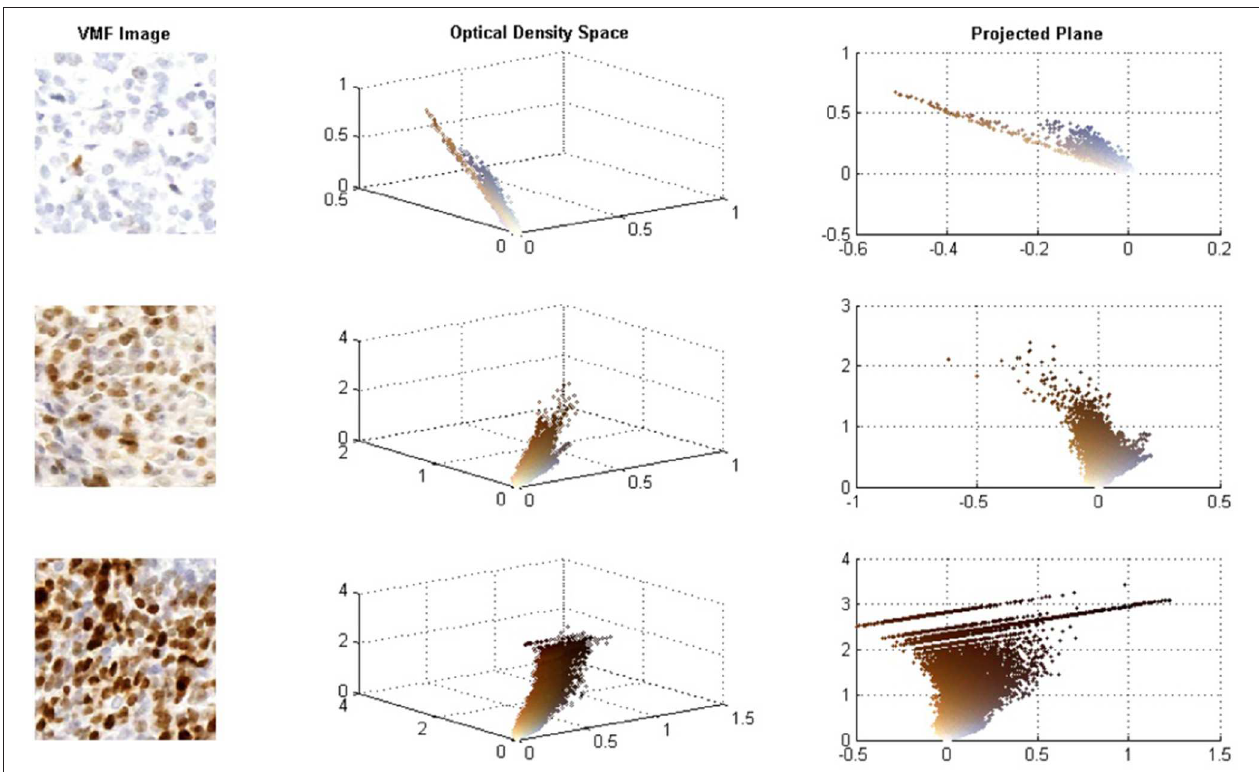
FIGURE 1 | (A) Sample images of low, intermediate, and high Ki67 stain concentrations. (B) RGB optical density space for respective images. (C) Projected plane obtained via principle component analysis on the RGB OD color